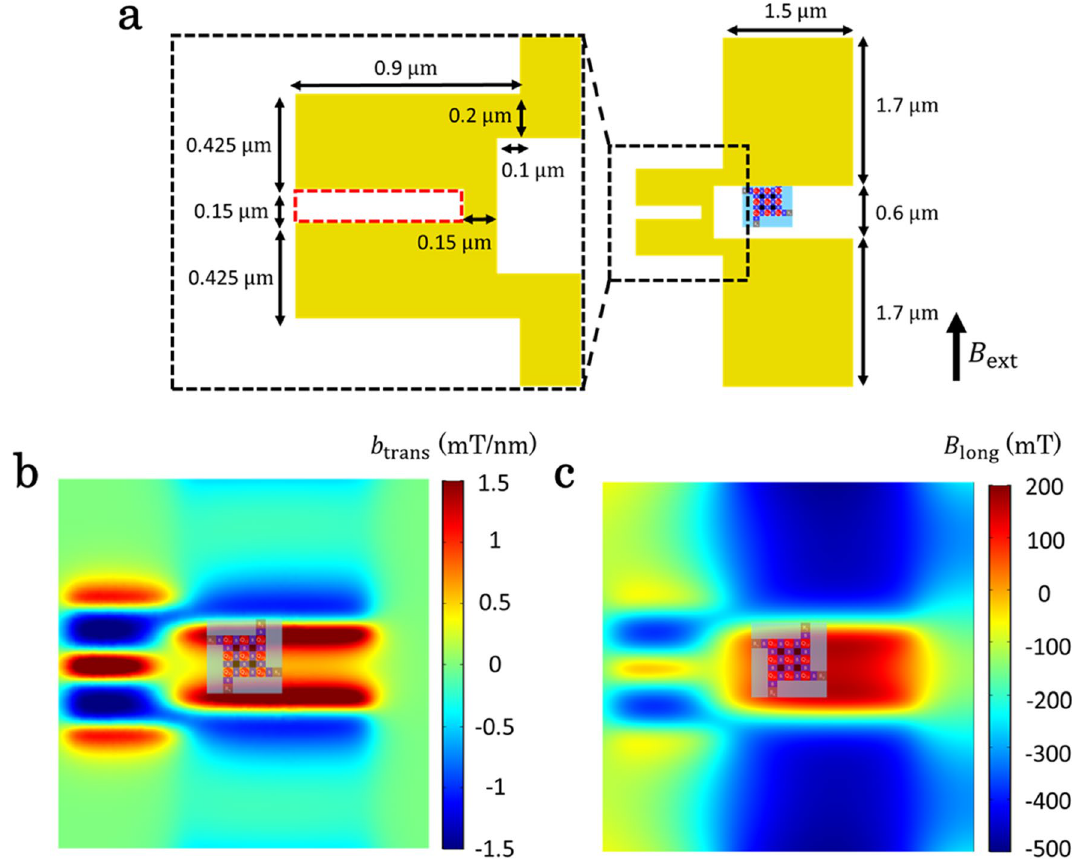
Figure 2. The schematics of MM design and simulation results. ( a ) MM design. The right panel illustrates the layout of the MM (yellow) along with the 3 × 3 QD array (center), designed so that the values of (cid:31) f r are robust against misalignment between the QD array and the MM. The magnet is 250 nm thick and 143 nm apart from the bottom of the magnet to the QD. Left panel shows an enlarged view of the region surrounded by the black dashed rectangle in the right. The magnet has a groove in the middle with its shape shown by the red dashed rectangle to make (cid:31) f r in each QD row moderate. B ext indicates the direction of the external magnetic field. ( b ), ( c ) Simulation results for b trans and B long in the Si QW. Magnetization of the MM is 1400 kA/m in the direction parallel to B ext . ( b ), ( c ) are drawn with COMSOL